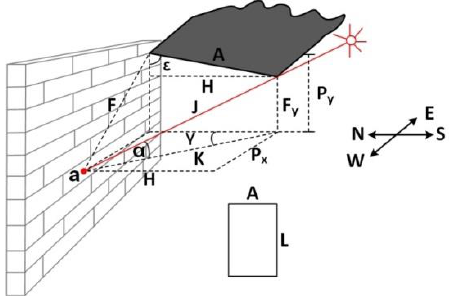
Figure 6. Inclined plate attached to a wall.